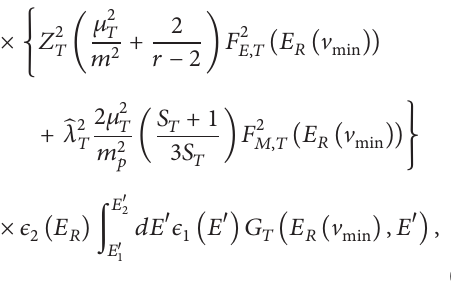
̃𝜂 lim ( V ) (as usual for SI interactions). Figures 4, 5, and 6 min include the DAMA modulation signal (green crosses), CoGeNT modulated (blue crosses), and unmodulated signal (plus an unknown flat background, dark red horizontal lines), CDMS-II-Si unmodulated rate signal (red crosses and limit line), CDMS-II-Ge unmodulated rate limit (light blue line) and modulation bound (dark grey horizontal line with down- ward arrow), XENON100 limit (purple line), and XENON10 suppression below 1.4 keVnr (orange S2-only limit without Q y line). The crosses represent the averages V 10 min ̃𝜂 𝑖 ( 𝑖 = 0 for